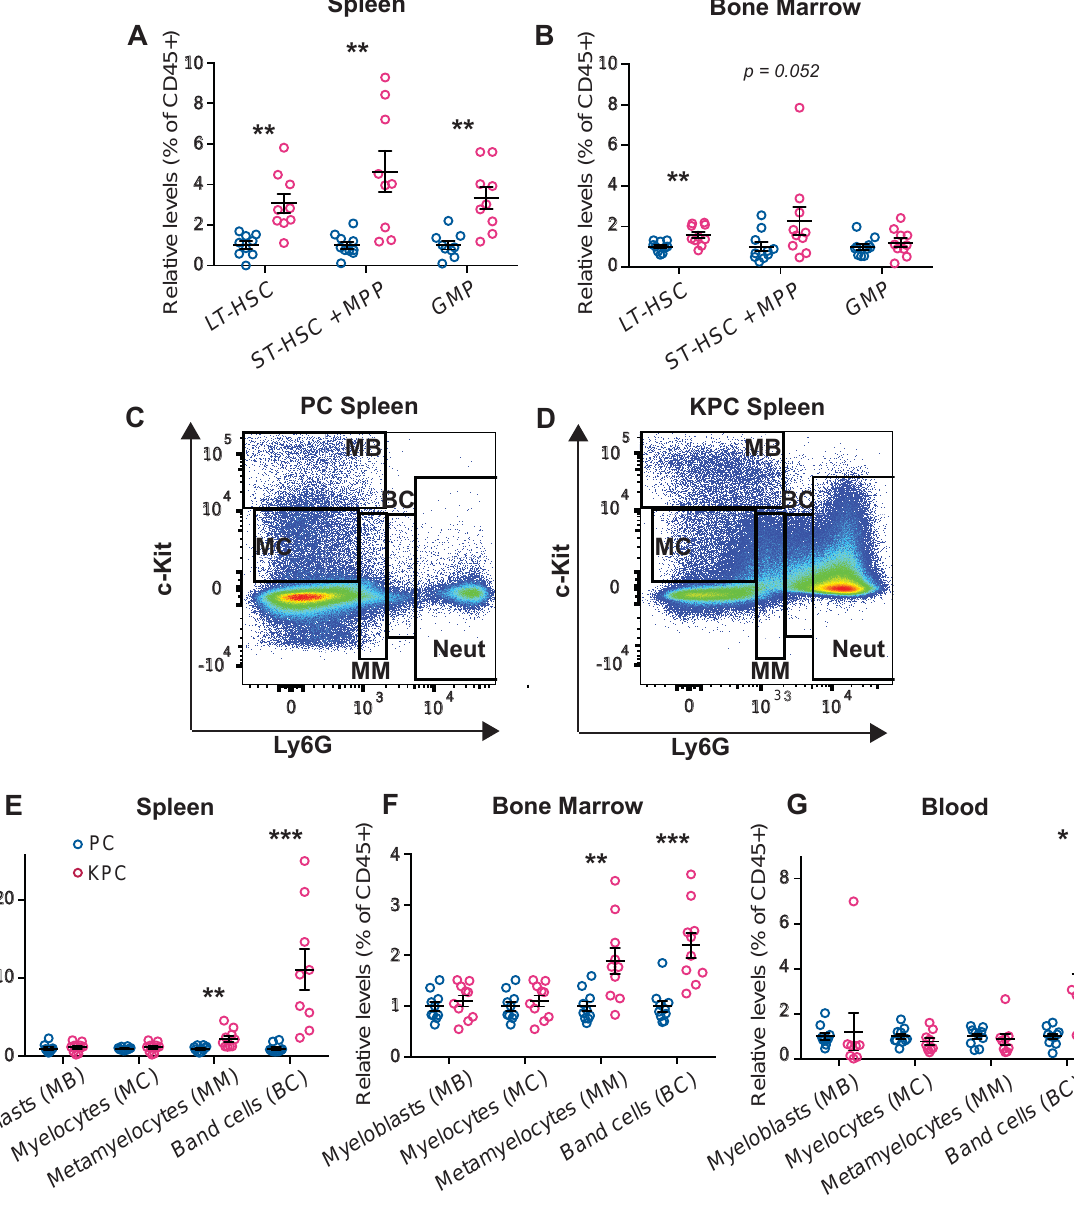
Figure 2. Quantification and FACS gating of progenitor cells, neutrophil precursors, and neutrophil populations in the KPC model. ( A , B ) Quantification of the HSC and progenitor cells (displayed as % out of all CD45+ cells) in the spleen ( A ) and bone marrow ( B ) of the pre-cachectic KPC and PC controls; ( C , D ) FACS gating strategy for neutrophils and neutrophil precursor populations in the spleen of the PC controls ( C ) and the pre-cachectic KPC mice ( D ); ( E – G ) Quantification of the neutrophil precursor populations (displayed as % out of all CD45+ cells) in the spleen € , bone marrow ( F ), and blood ( G ) of the pre-cachectic KPC mice and the PC controls. The data are expressed as the mean ± SEM. Statistical differences were examined using unpaired two-tailed Student’s t -test with Welch’s correction. * p -value < 0.05, ** p -value < 0.01, *** p -value <